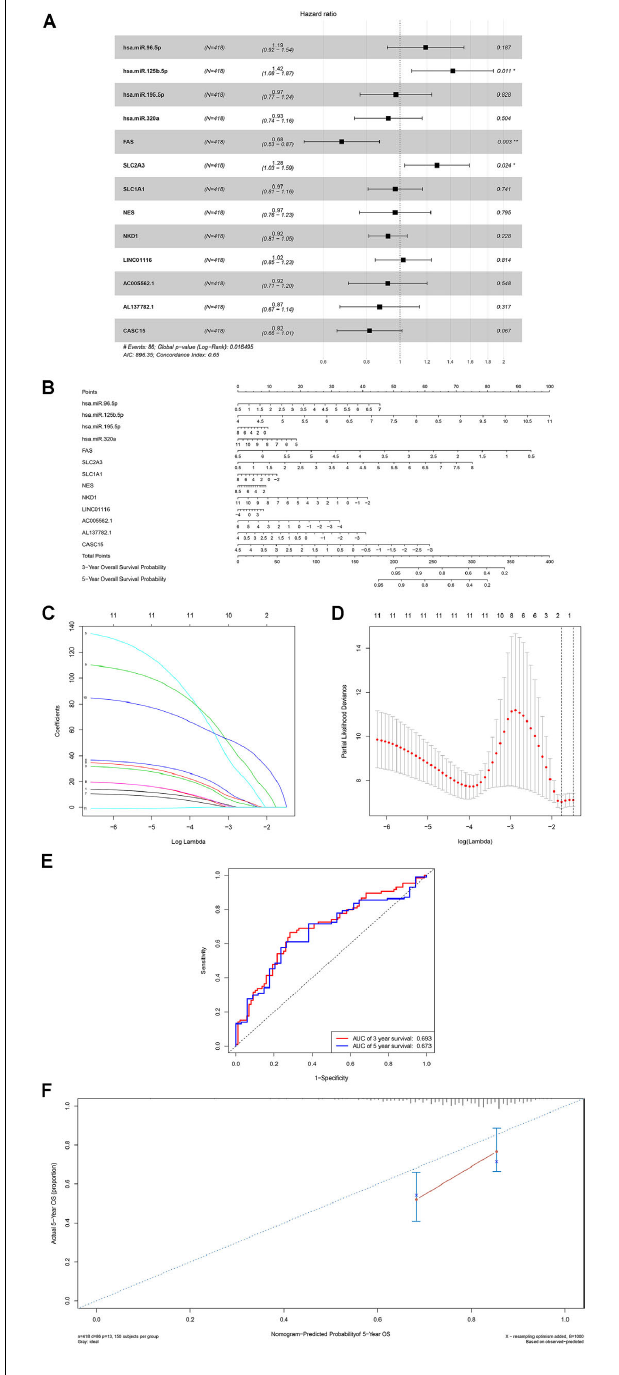
FIGURE 4 | The results of the multivariate Cox regression (A) , nomogram (B) and model diagnosis process Lasso regression and ROC curves (C–F) which were constructed by the significant members of the ceRNA network. ROC, receiver operating characteristic curves. * P < 0.05.